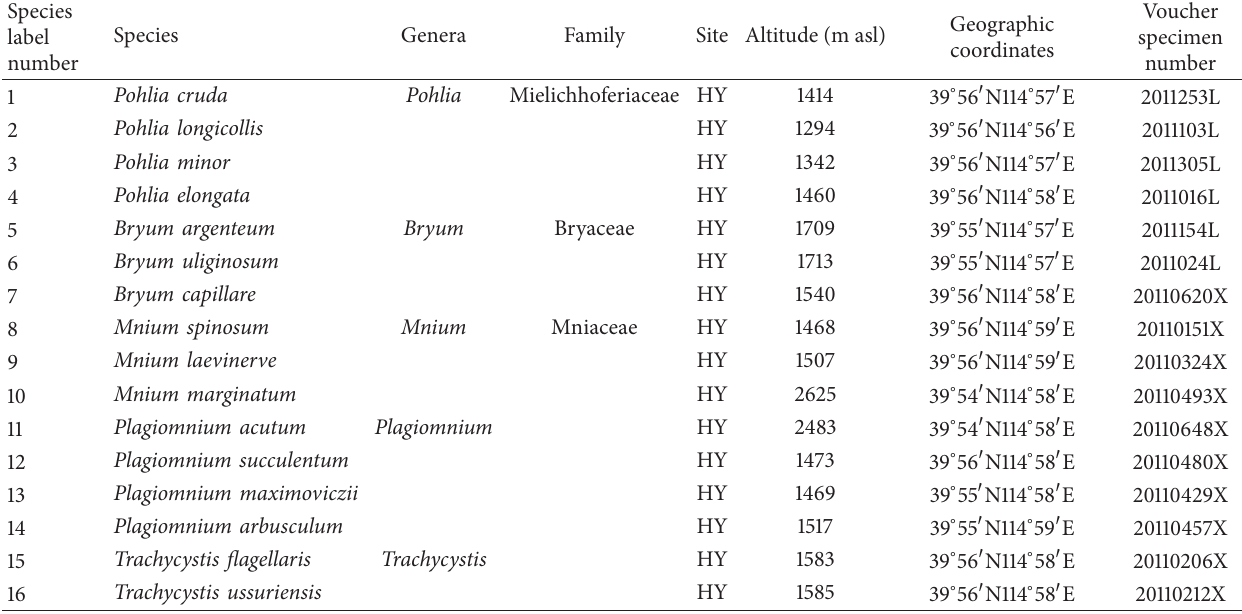
Table 1: Description of the geographic coordinates and altitudes of the sample sources.